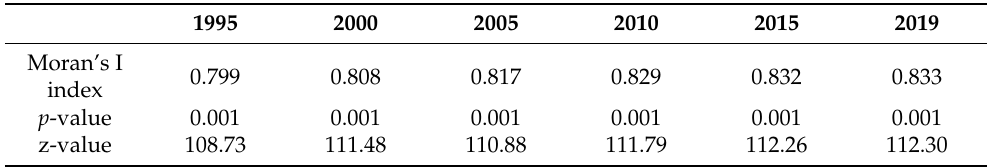
Table 6. Spatial correlation between carbon emissions and UCL area in Wuhan City, 1995–2019 and the significance test results.